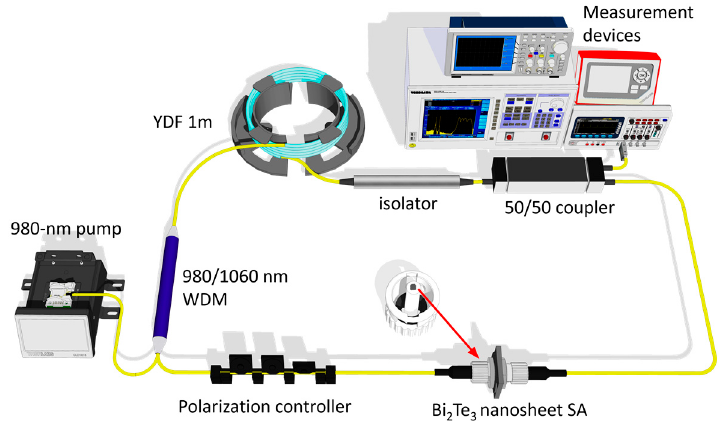
Figure 3. Proposed configuration of the mode-locked YDFL with Bi 2 Te 3 SA.